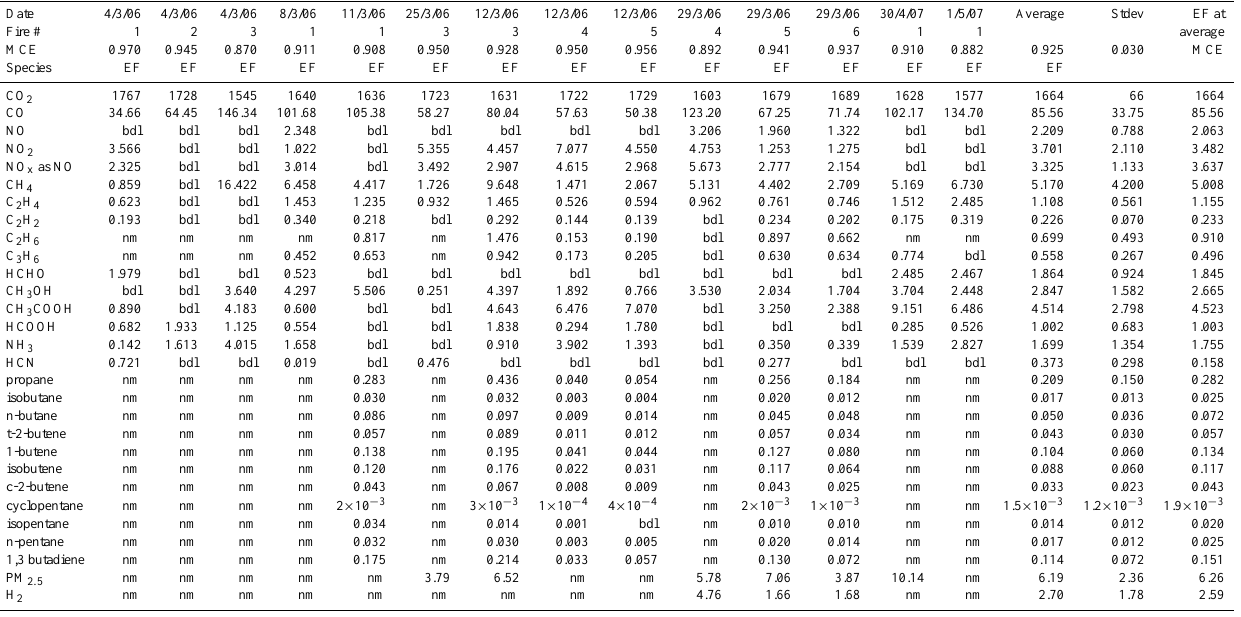
Note: “nm” indicates not measured, “bdl” indicates the mixing ratio was below the detection limit, but the EF value may not be low (see Sect. 2.3).